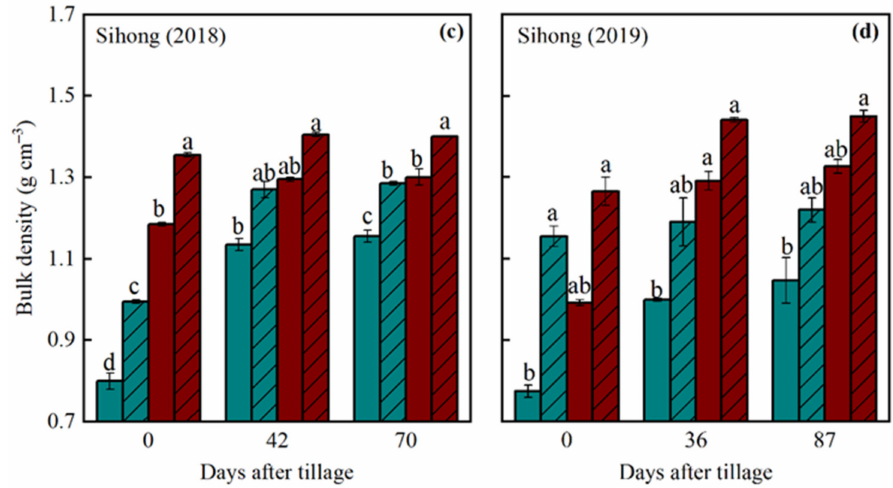
Figure 3. Effect of tillage methods on soil bulk density (BD) at 0–10 cm and 10–20 cm soil layers at different days after tillage at Jintan ( a , b ) and Sihong ( c , d ) in 2017–2018 ( a , c ) and 2018–2019 ( b , d ). Tillage methods included plow tillage followed by rotary tillage (PR) and no-tillage (NT). All values are presented as mean ± SE (3 replicates) with one standard error. For the same time after tillage, bars labeled with different letters indicate significant differences among different tillage methods and soil layers at the p < 0.05